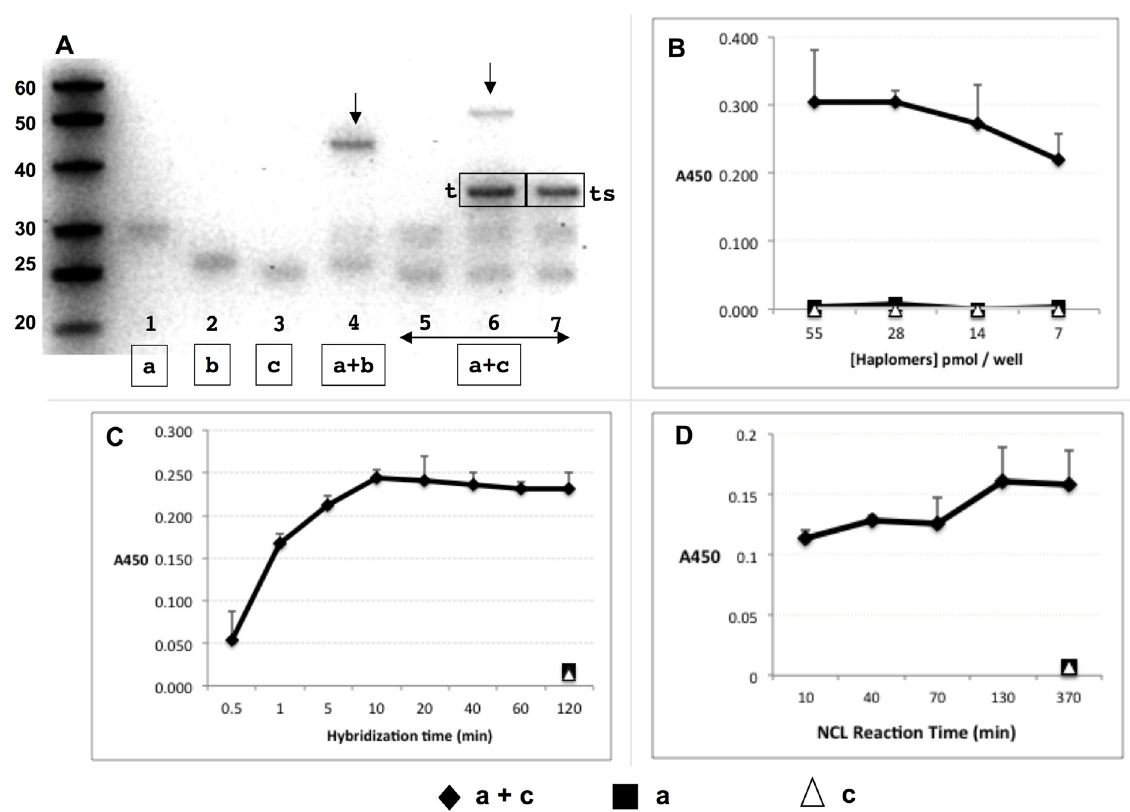
Figure 2. Trastuzumab haplomer reactivities. ( A ) Formation of NCL reaction products via haplomer templating, with 30 pmol haplomers 20 µL / 16 h incubations in phosphate buffer pH 7.5 with 1 mM TCEP, where 1.5 pmol of each haplomer (structures as in Figure 1) is present per 15% denaturing gel lane. Haplomer codes correspond to structures in Figure 1 (haplomer [a] = oligonucleotide #440 click conjugated to peptide A444; haplomer [b] = oligonucleotide #441 click conju- gated to peptide A423; haplomer [c] = oligonucleotide #439 click conjugated to peptide A423). Lanes 1–3: haplomer [a] and reduced haplomers [b] and [c] alone, respectively; Lane 4: mutually complementary [a] + [b] , with product band shown by arrow, Lane 5-7: [a] + [c] haplomers alone; in the presence of equimolar specific mutual template (marked [t] in gel), or with corresponding scrambled template (marked [ts] in the gel), respectively. Product band only observed